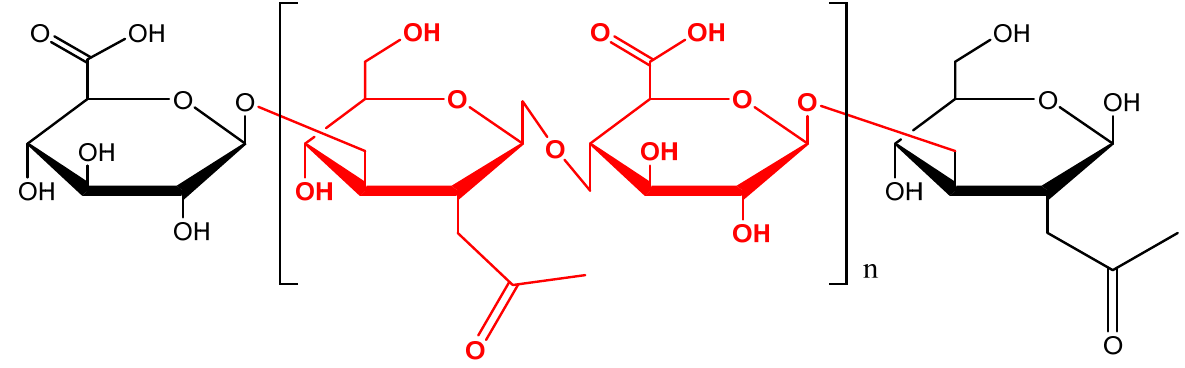
Figure 1. Chemical structure of hyaluronic acid (HA).